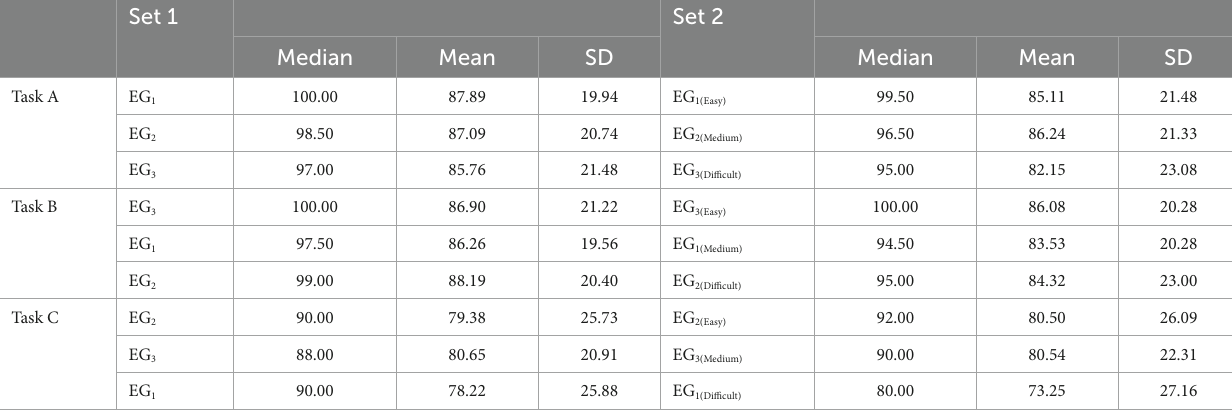
TABLE 3 Mean difference in students’ self-efficacy between Set 2 (easy-, medium- and difficult-level marking) and Set 1 (without level marking). Set 2 – Set 1 Mean difference in students’ self-efficacy Easy-level marking – Without level marking −